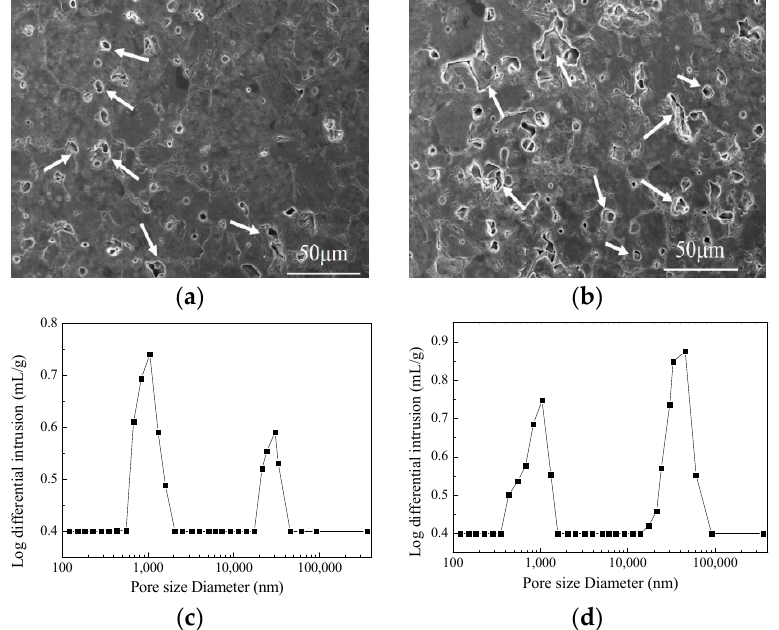
Figure 5. SEM micrographs and pore size distributions of samples with 12 mm using vacuum compaction molding ( a , c ) and conventional compaction molding ( b , d ).